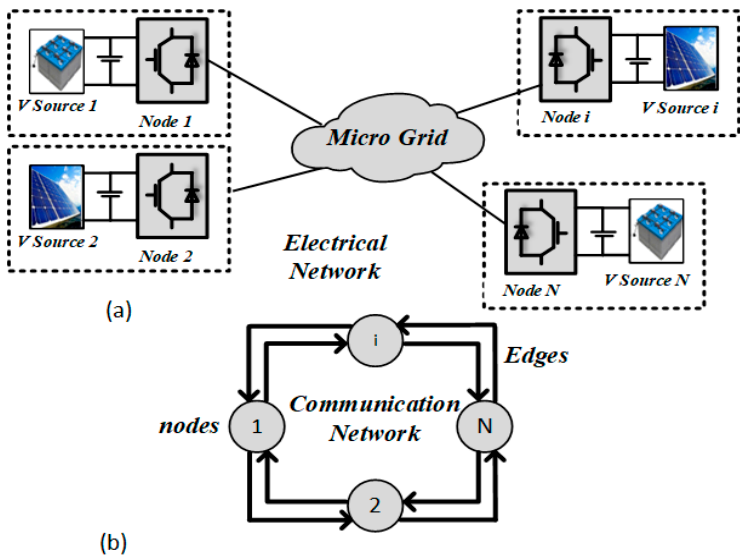
Figure 1. General layout of a micro-grid: ( a ) Power-supplying nodes; ( b ) Communication network spanned among nodes for data exchange.